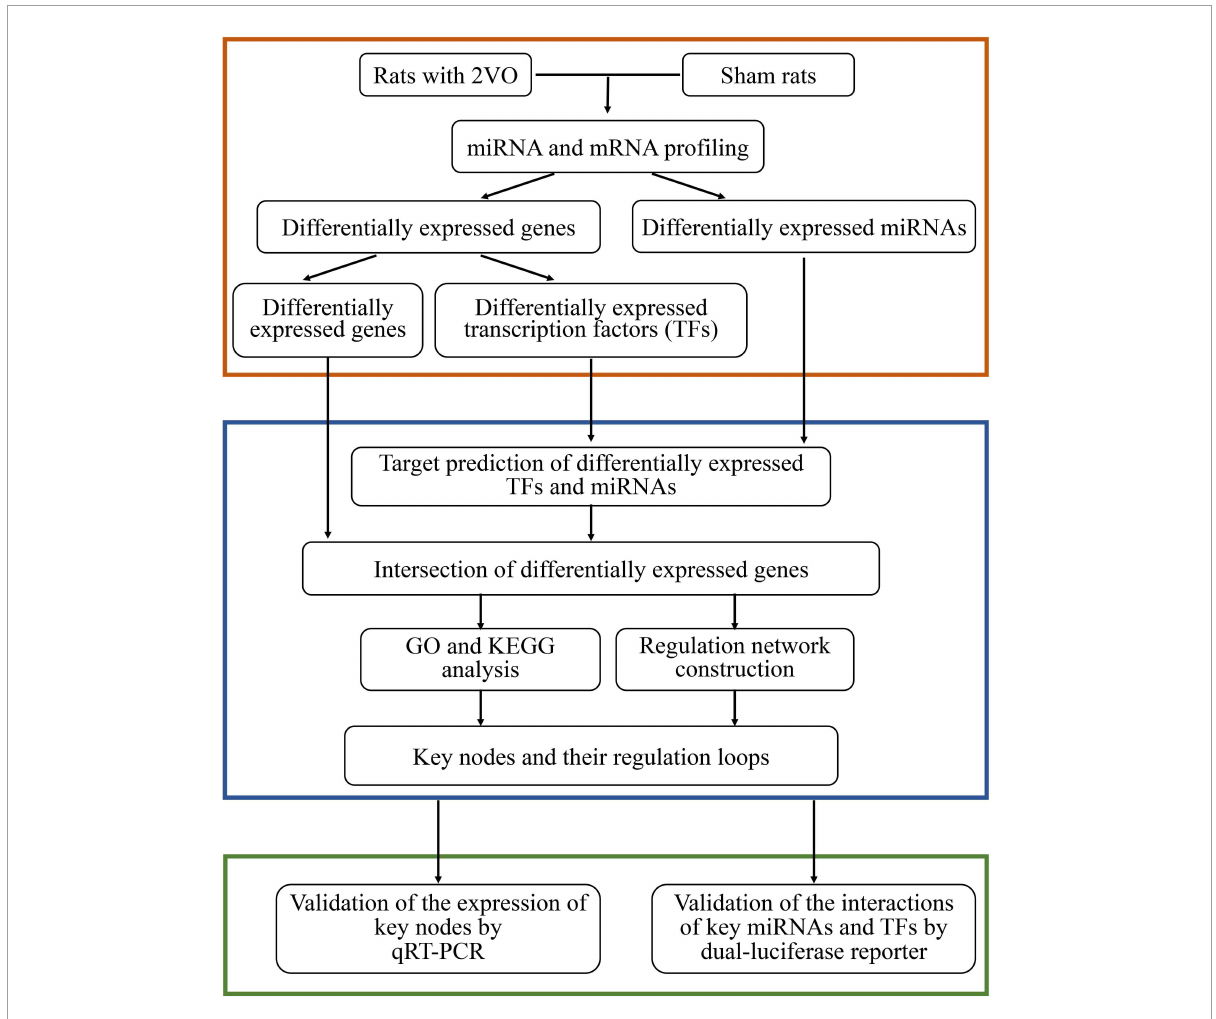
FIGURE1 Workflow of the present